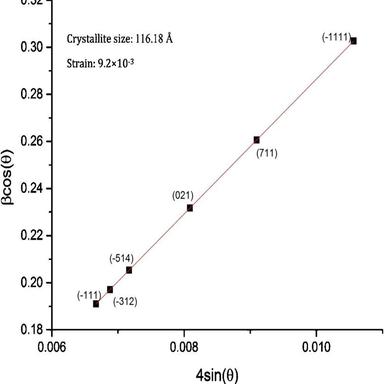
Williamson-Hall analysis of IBS films. The crystallites size is approximately 11.6 nm.